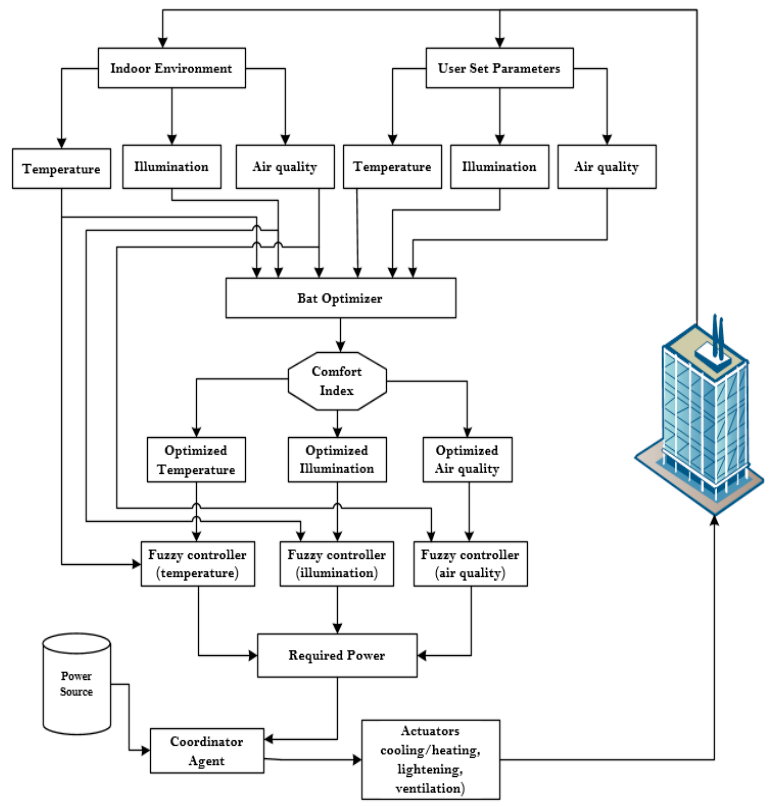
Figure 3. Energy Consumption Optimization and Managing User Comfort in Residential Building Using Bat Algorithm and Fuzzy Logic.